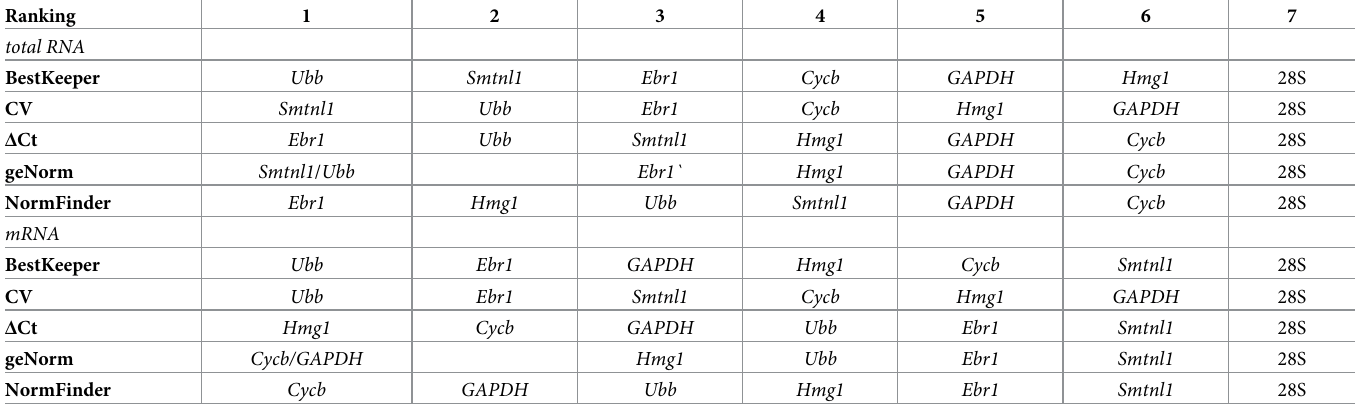
Table 3. Stability ranking of candidate reference genes given upon BestKeeper, CV, Δ Ct, geNorm and NormFinder. Ranking 1 2 3 4 5 6